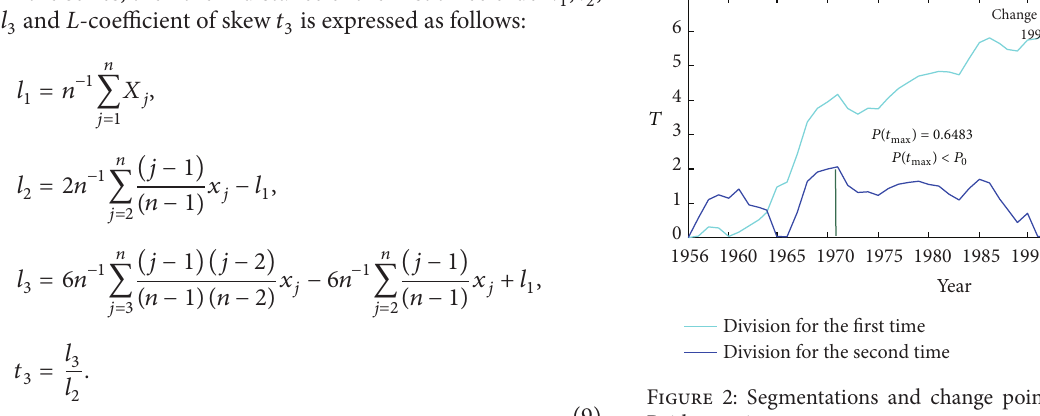
Figure 2: Segmentations and change points of annual runoff at Beidao